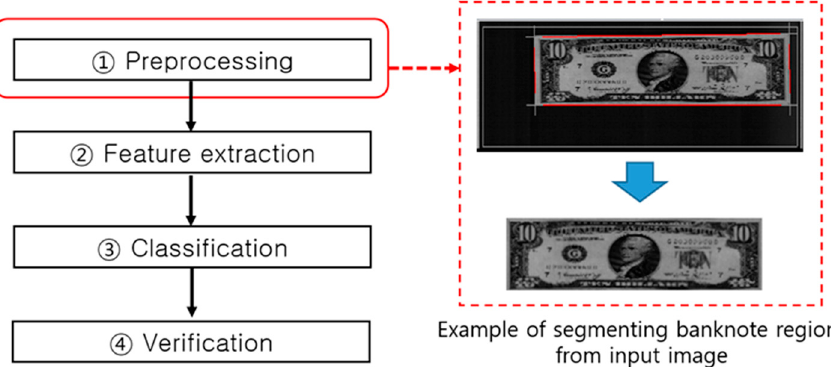
Figure 6. Preprocessing step in the banknote recognition process flow.